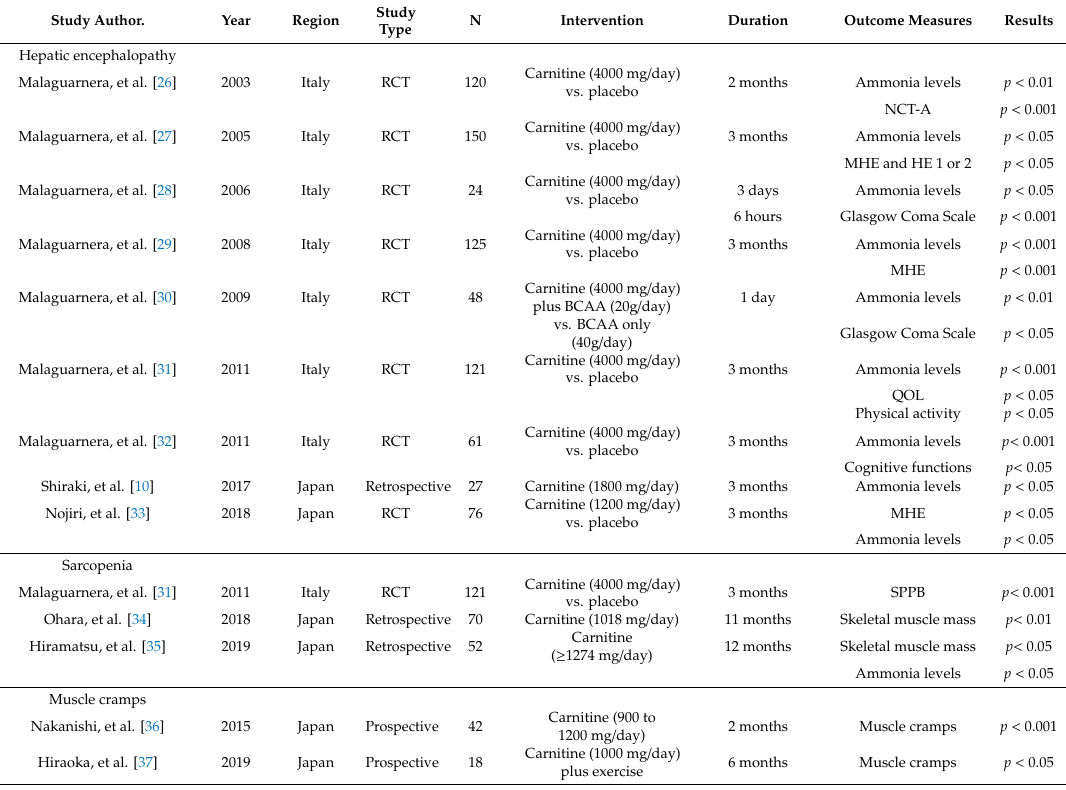
Table 4. Di ff ering doses of carnitine supplementation in various studies.